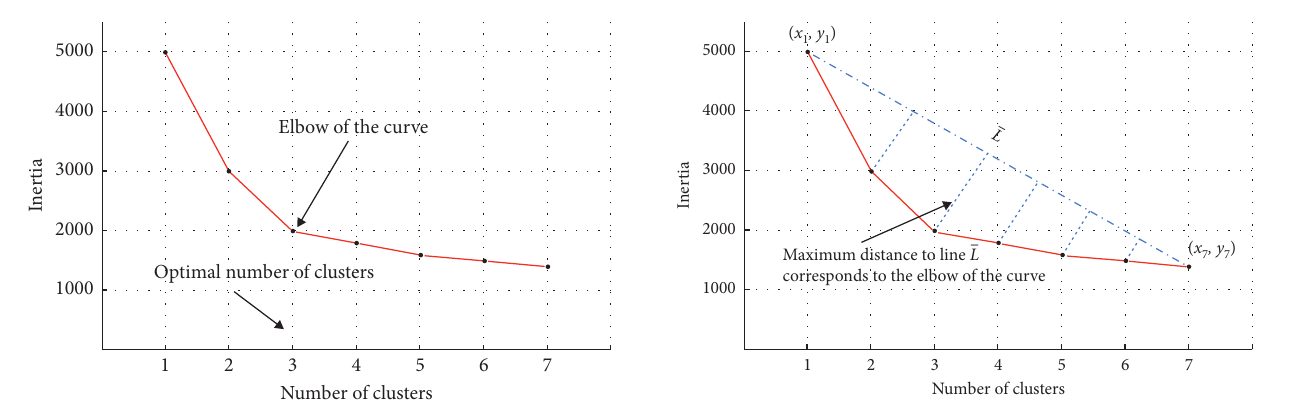
Figure 4: Obtaining the elbow point of the curve mathematically by calculating the maximum of perpendicular distances between curve points and line L